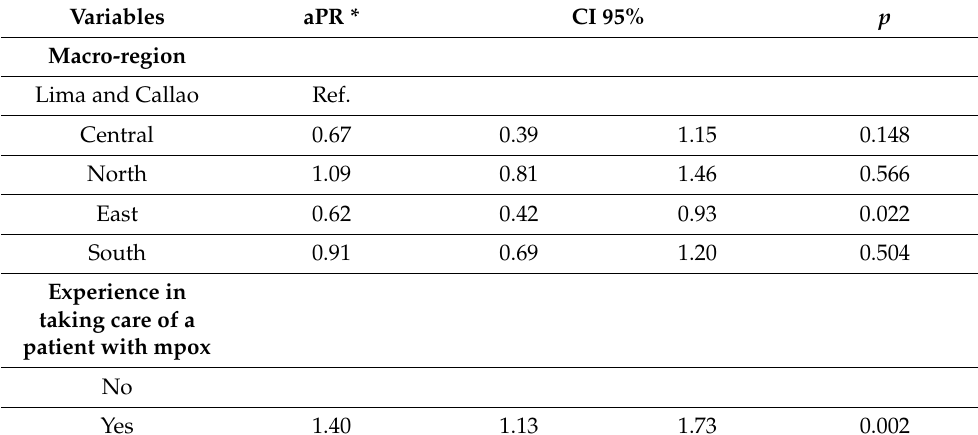
Table 4. Multivariate analyses of the factors associated with a higher level of knowledge about